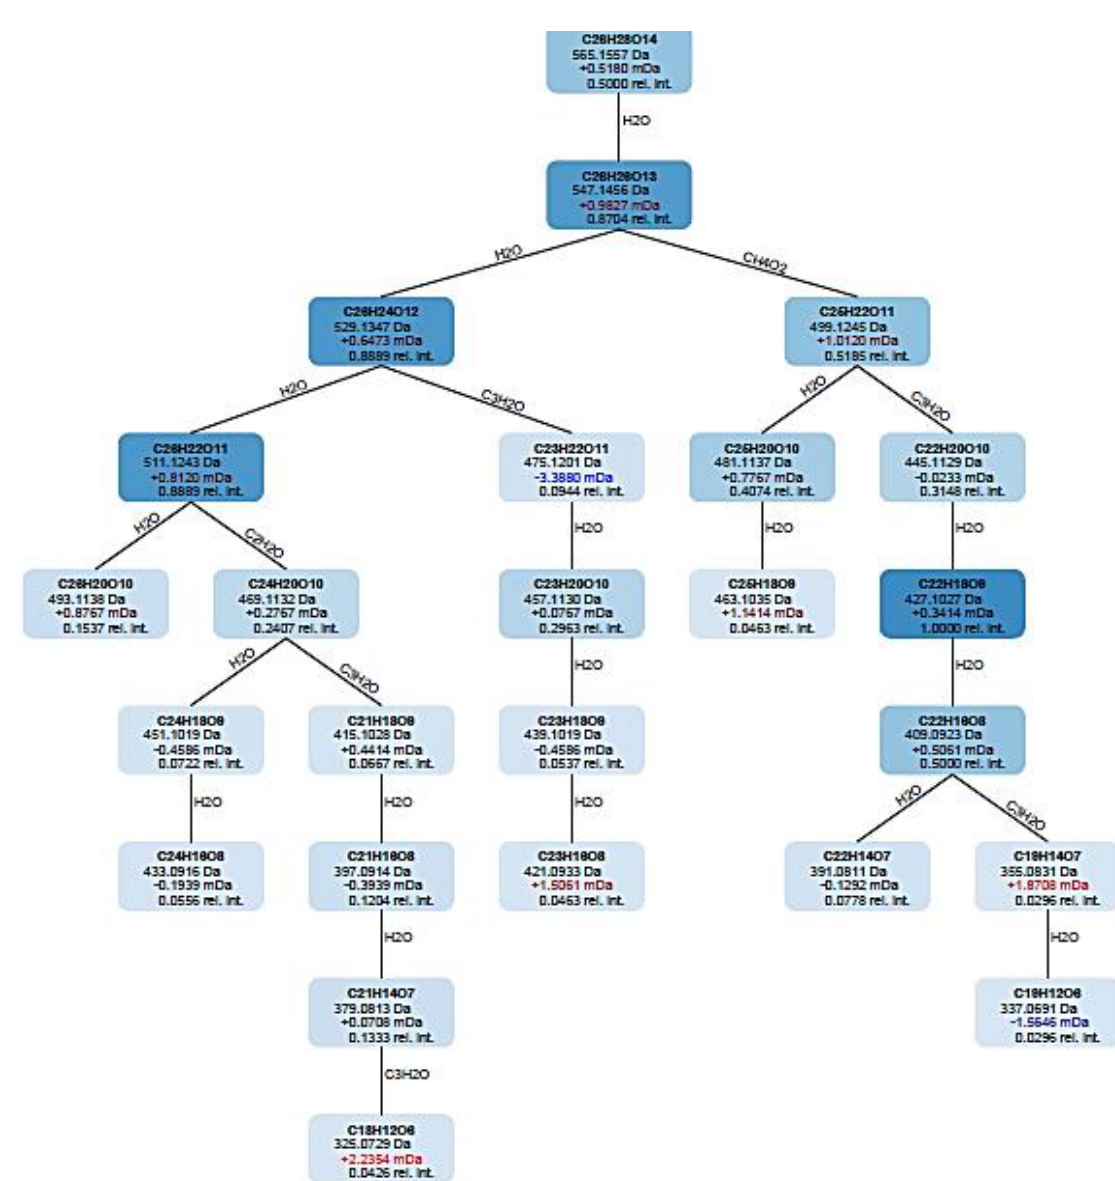
Figure 7. The fragmentation tree of candidate 2 with 565.16 m/z annotated as isoschaftoside. Candidate structures for the phytochemicals of E. indica fed and non-fed pitchers